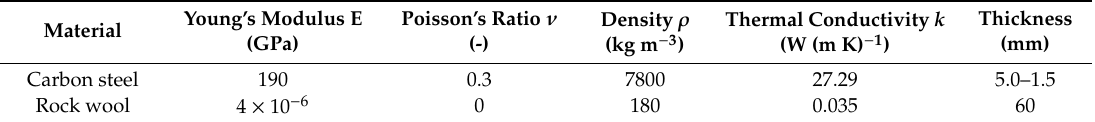
Table 1. Material properties at 20 ◦